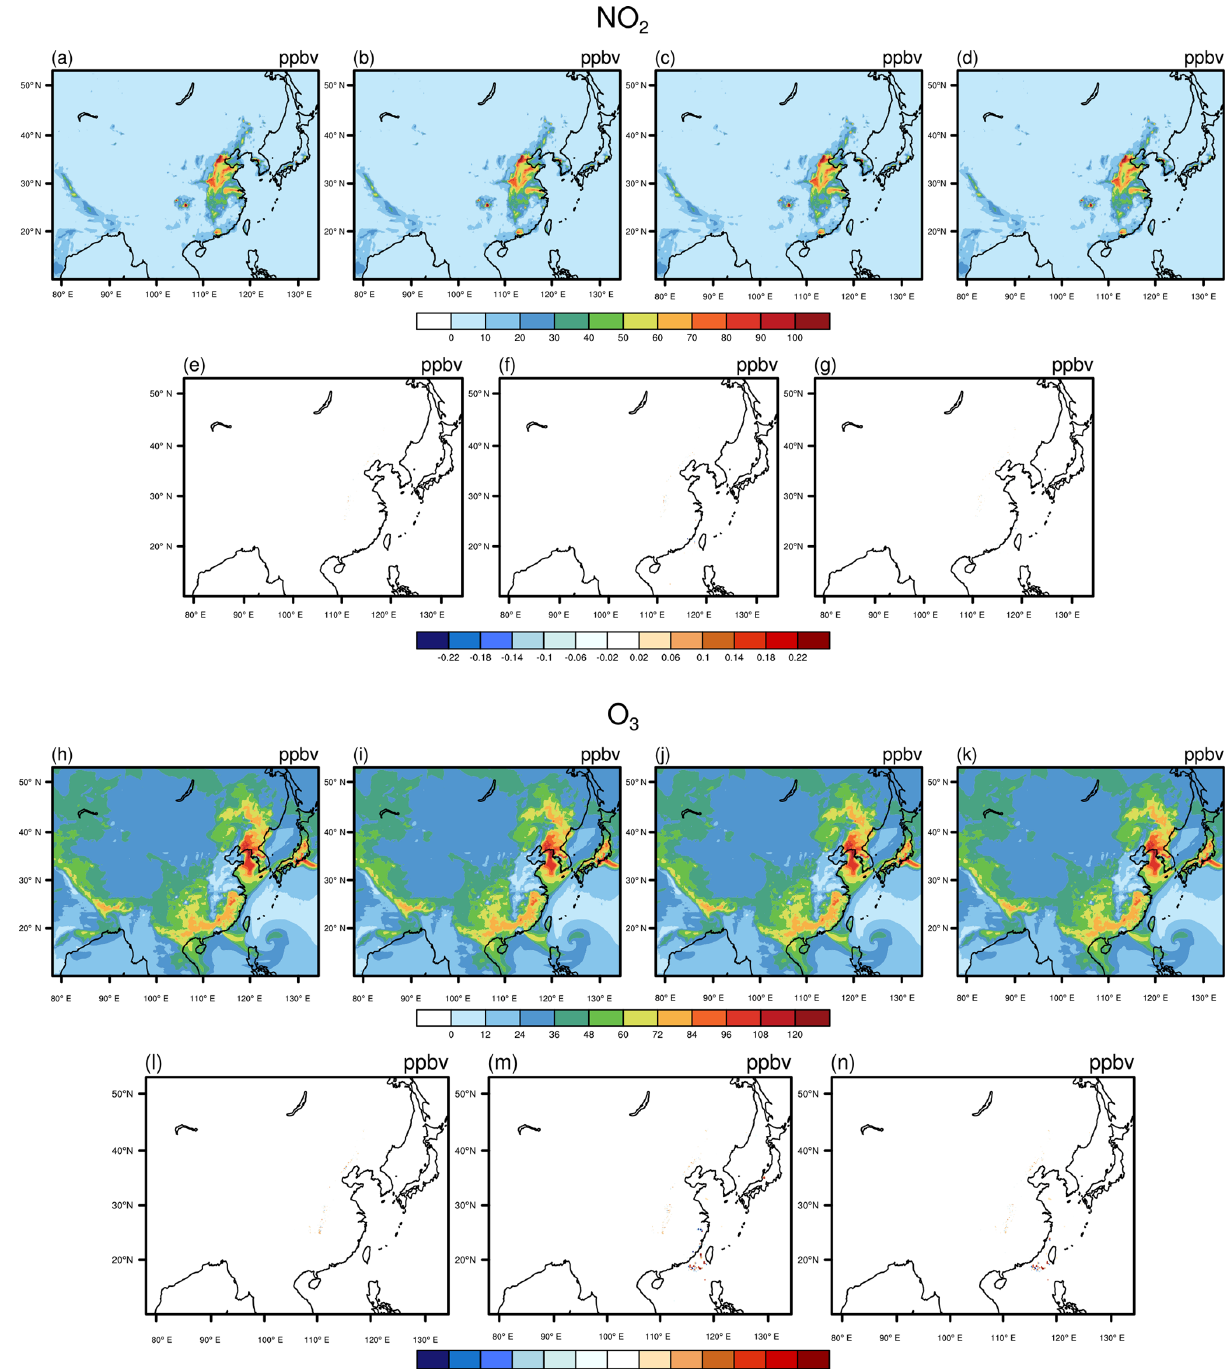
Figure 5. NO 2 and O 3 concentrations outputted by baseline and optimized code with different accuracy compile flags. Panels (a) and (h) are from baselines code compiled by the precise option, which are treated as benchmark for comparison. Panels (b) and (i) are from optimized code compiled by the precise option. Panels (c) and (j) are from baseline codes compiled by the fast = 1 flag. Panels (d) and (k) are from optimized code compiled by the fast = 1 flag. Panels (e–g) and (l–m) are the output concentration differences of optimized code (precise), baseline code (fast = 1), and optimized code (fast = 1) compared with baseline code (precise).